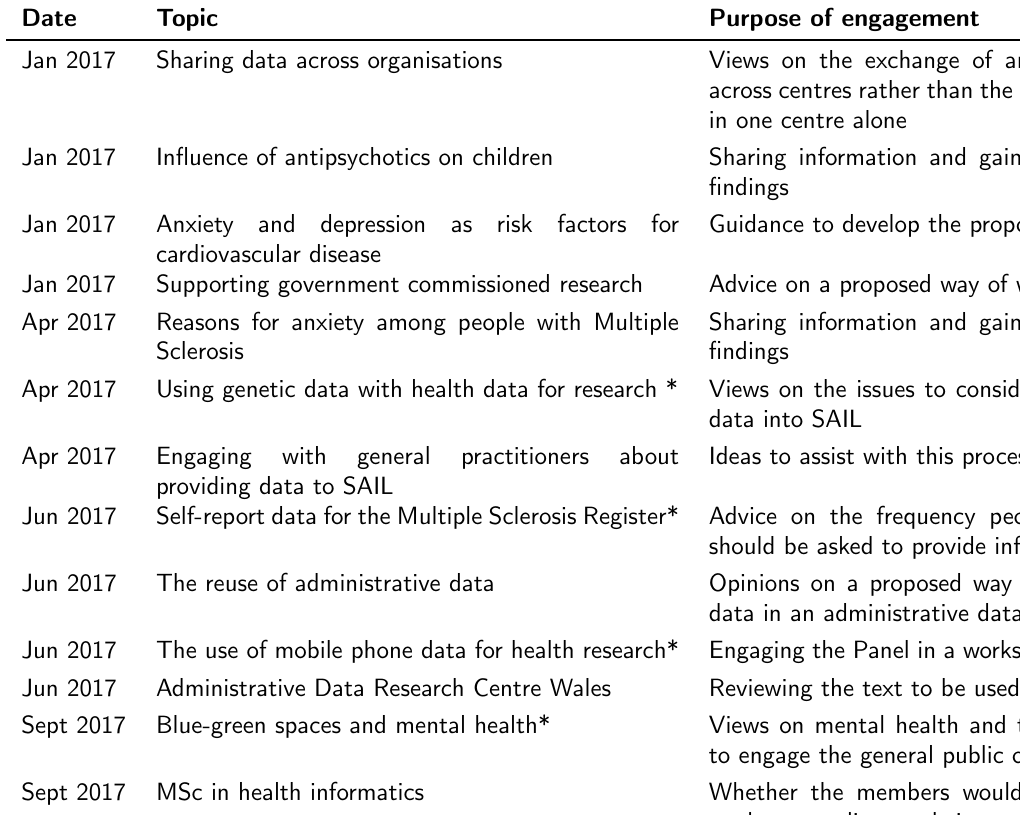
Table 1: Topics discussed by the Consumer